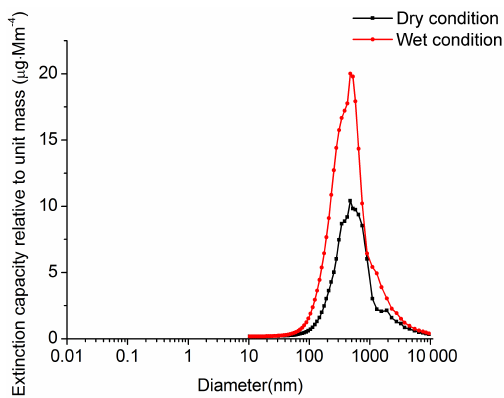
Figure 8. Extinction capacity relative to unit mass in different size segments under dry/wet